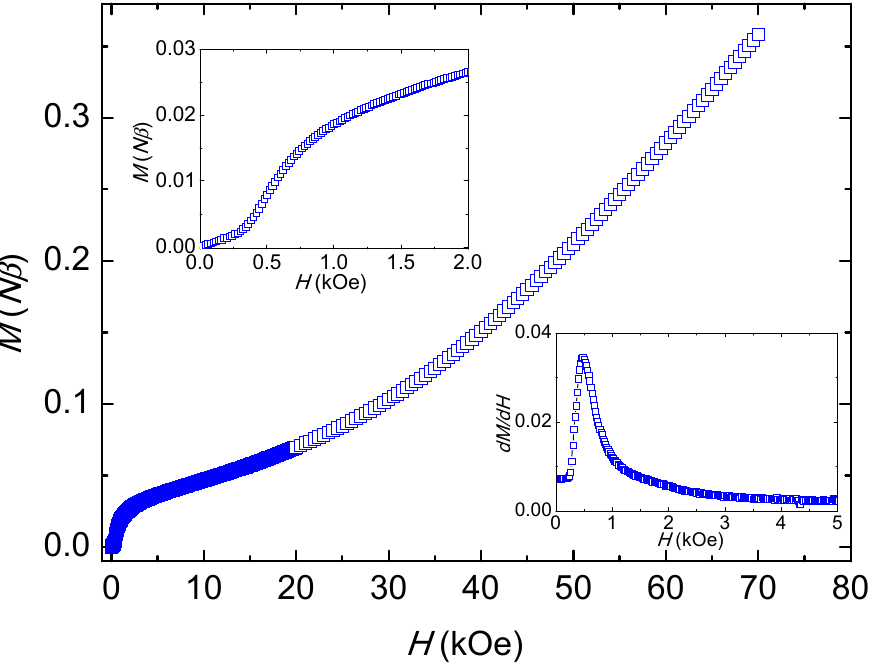
Figure 5. Isothermal magnetization of compound 1 at 1.8 K. The insets give the low field range and the derivative of M vs. H .